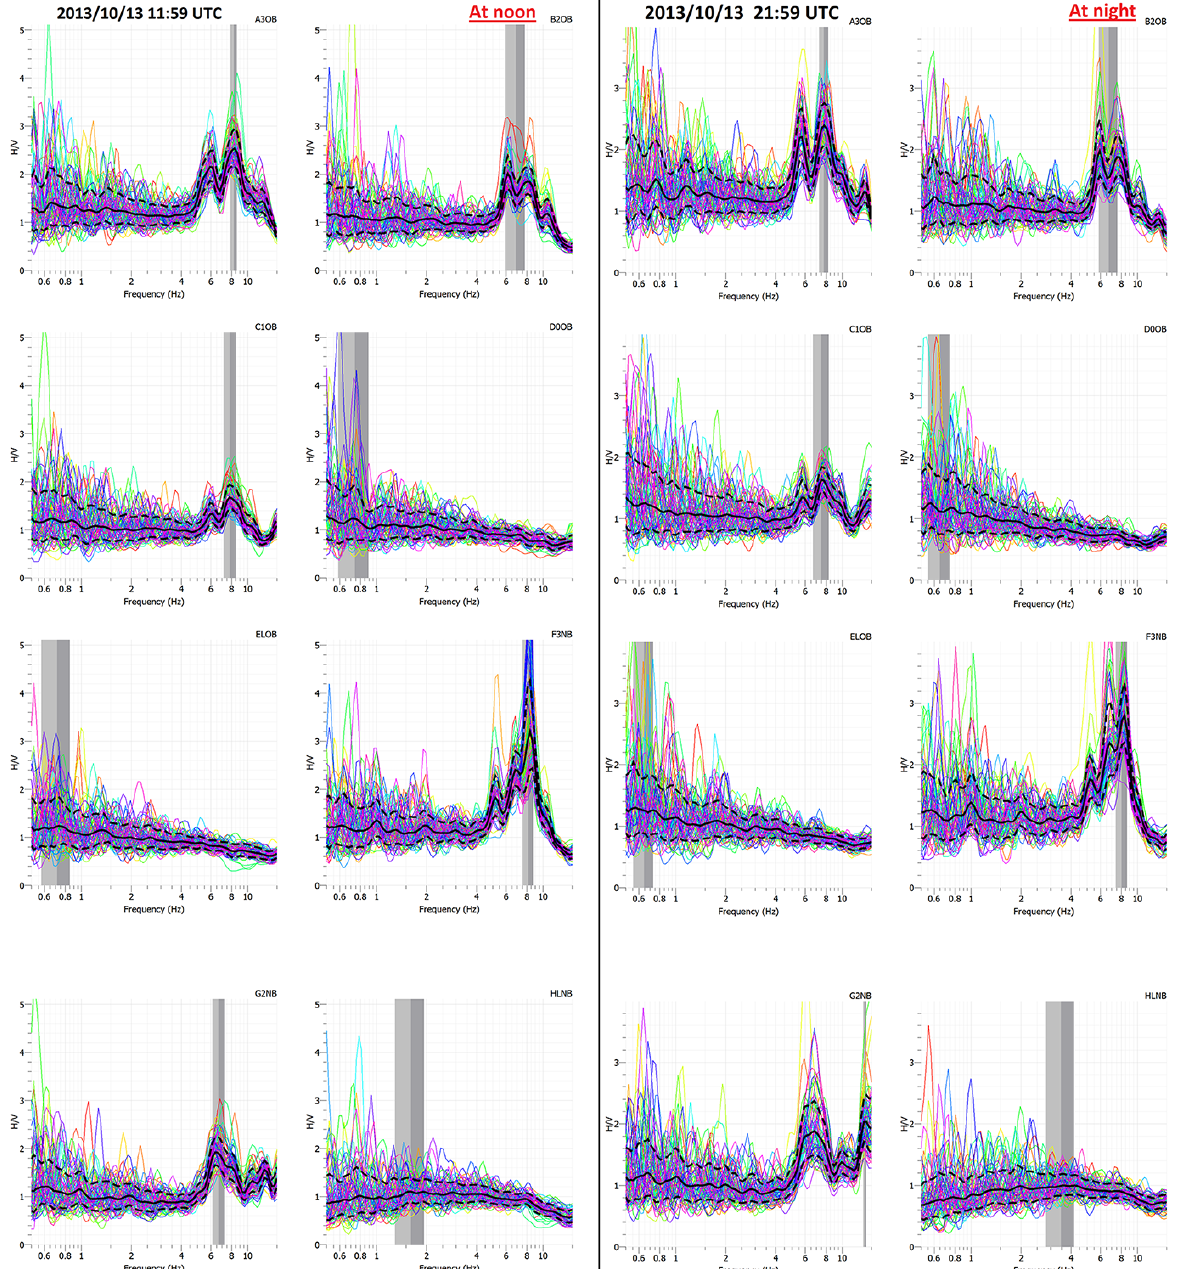
Figure 17. HVSR analysis of ambient noise recording with time duration of